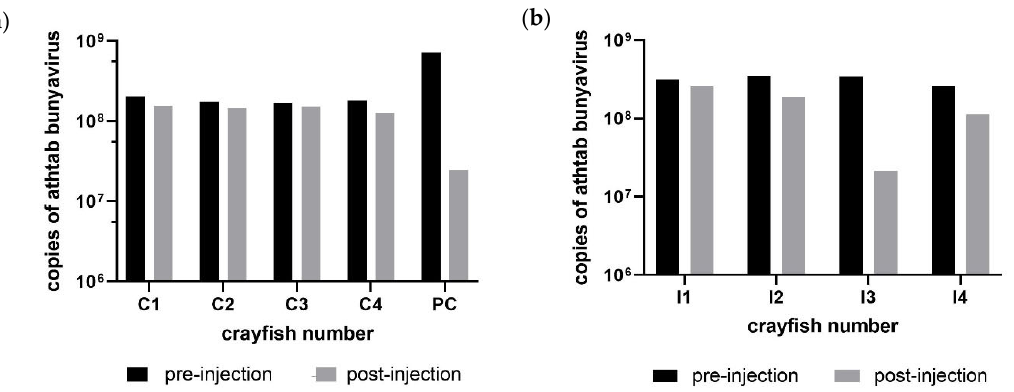
Figure 2. ( a ) Difference in copy number of Athtab bunyavirus before and after 14 days of PBS injections in the control and in-contact, procedural control (PC) group for Experiment 1. ( b ) Difference in copy number of Athtab bunyavirus before and after 14 days in the virus injection group for Experiment 1.